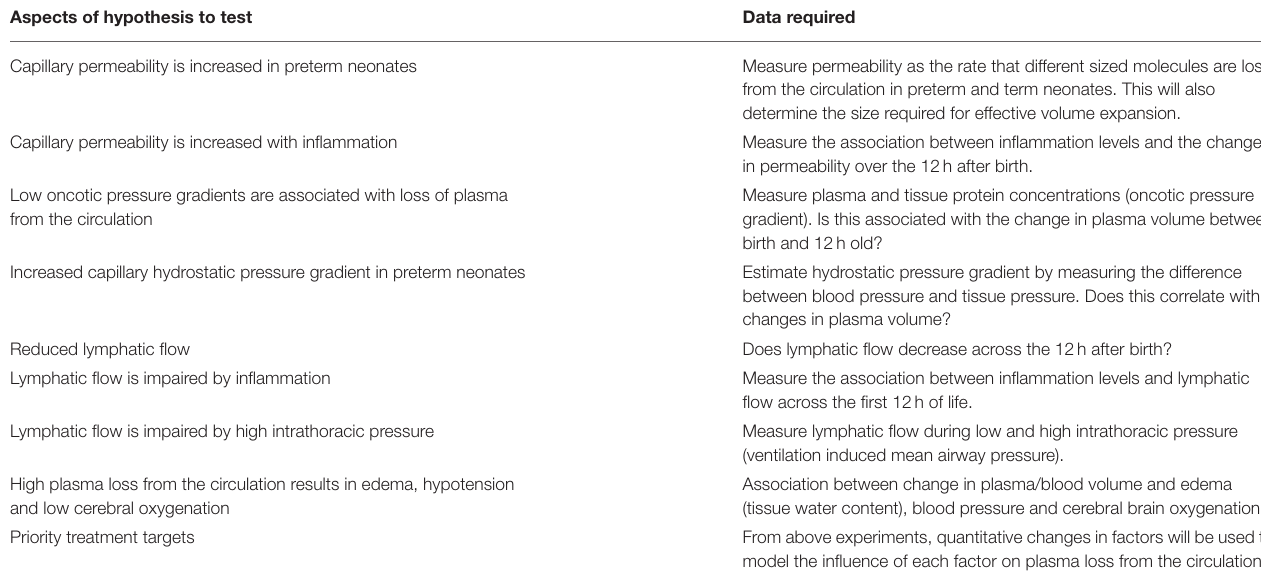
TABLE 1 | Experiments in preterm and term piglets to test our working hypothesis. Aspects of hypothesis to test Data